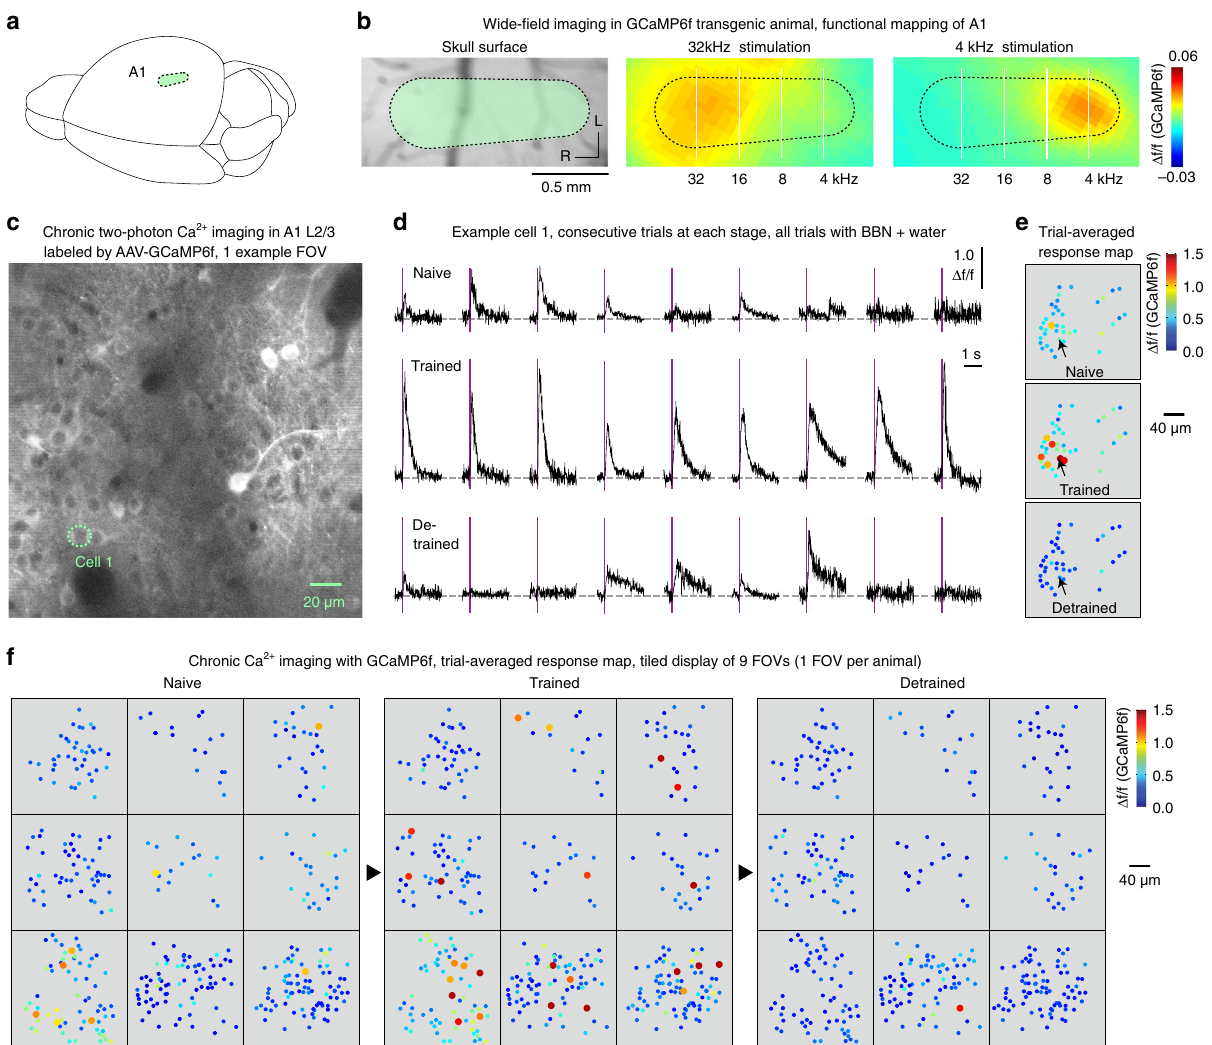
Fig. 2 Chronic two-photon Ca 2 + imaging with GCaMP6f in A1 L2/3 across training stages. a Cartoon illustration of a mouse brain; the green patch outlines the primary auditory cortex (A1). b Left image: skull surface above the right auditory cortex, green patch outlines A1; middle and right images: wide fi eld imaging (in a GCaMP6f-expressing mouse), fl uorescence response to pure-tone stimulation with 32 and 4 kHz, respectively. Black dotted lines outline the A1 boundary. c Example two-photon image (averaged 100 frames) in A1 L2/3 of a head- fi xed behaving mouse. d Consecutive trials of sound- evoked Ca 2 + signals in an example cell (Cell 1 outlined by a dotted circle in ( c )) at different training stages. e A pseudo-coloured map of sound-evoked Ca 2 + response amplitudes (trial-averaged) at different stages (of the same fi eld of view (FOV) as in ( c ), with an arrow pointing to the same example cell as in ( d )). Cells with Δ f / f (GCaMP6f) ≥ 1.0 are highlighted by enlarged dots (2-fold diameter). f Similar to panel e , pseudo-coloured neuronal response maps (minimum 3 trials per stage) for all FOVs (1 FOV per animal, 9 animals) at each